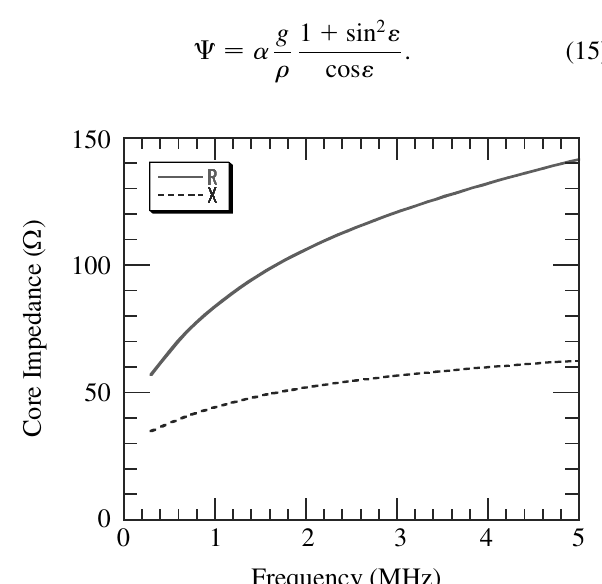
FIG. 10. Frequency dependence of complex impedance ( Z (cid:5) R (cid:1) jX ) of the racetrack-shaped MA core described in Fig.